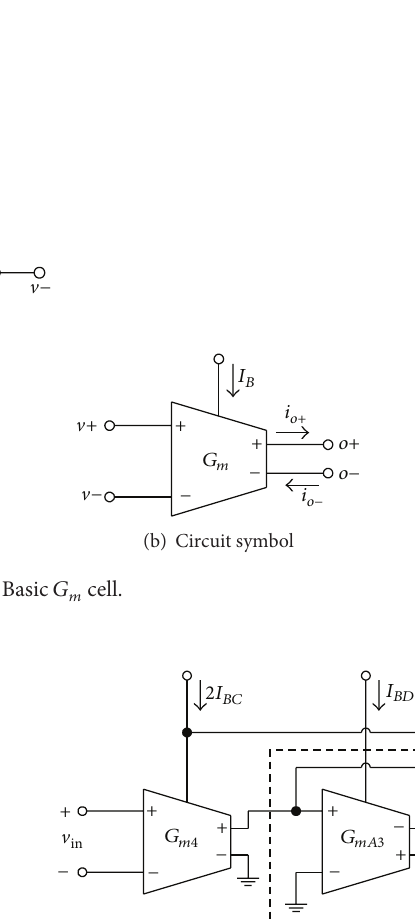
Figure 1: Schematic symbol of the CFTA.